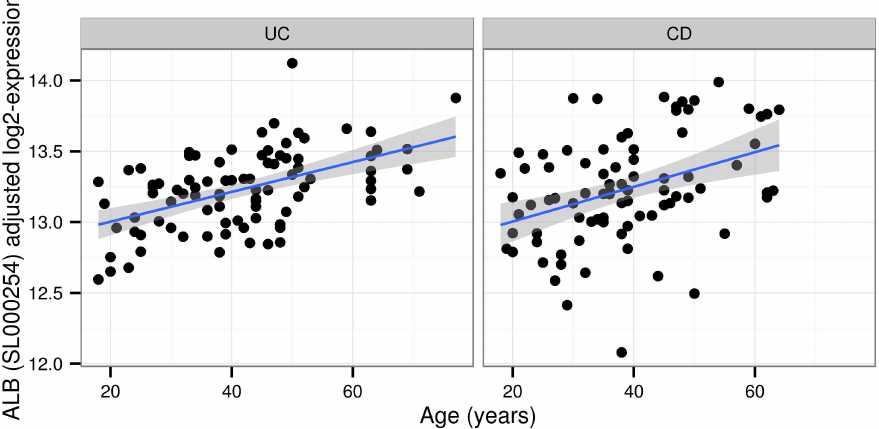
Fig 2. Increaseof Albumin levels with aging in CD and UC. Scatterplot of the Albumin protein level vs patients age, separately for UC patients (left panel)and CD patients (baselinedata only is displayed, right panel). Age in years on the horizontal axis; mean-centered and adjustedlog2-protein expressionon the vertical axis (adjustedfor sex and